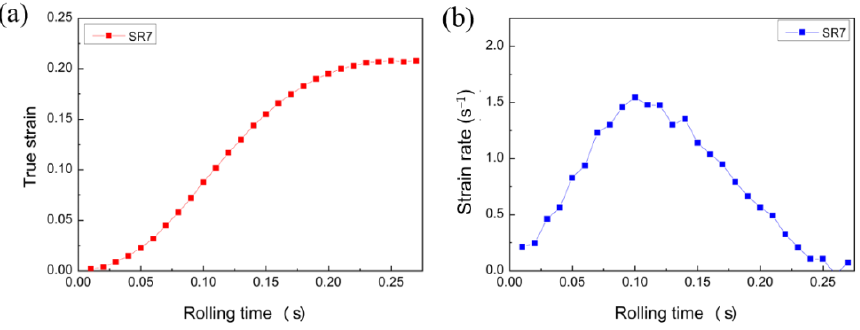
Figure 4. ( a ) change in stress field, ( b ) evolution of strain rate.